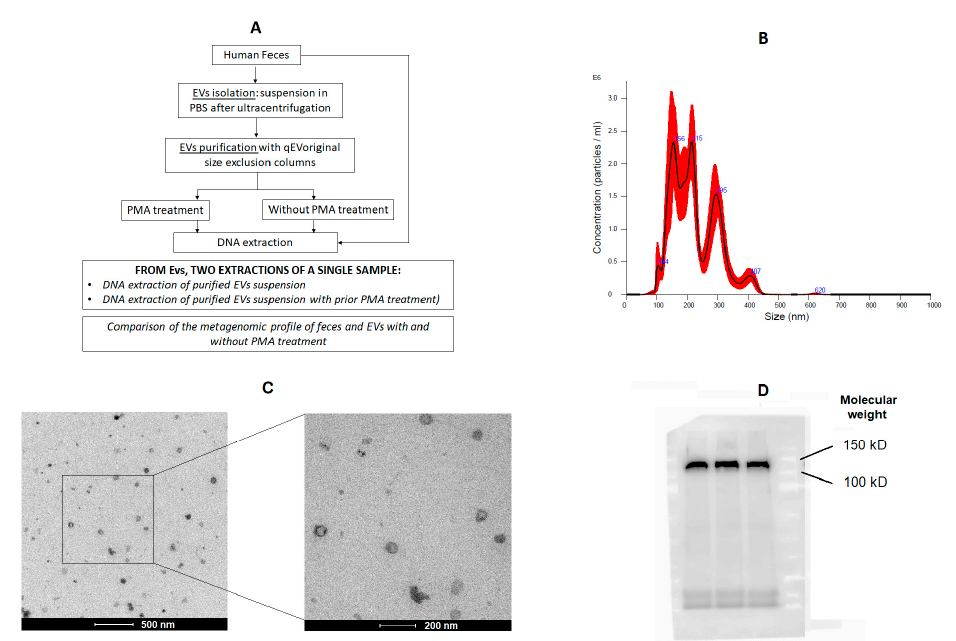
Figure 1. ( A ) Detailed scheme of the assay using Propidium Monoazide (PMA) treatment before DNA extraction and sequencing. Characterization of fecal-microbiota-derived EVs by ( B ) nanoparticle tracking analysis (NTA), ( C ) transmission electron microscopy (TEM) and ( D ) Western blot.